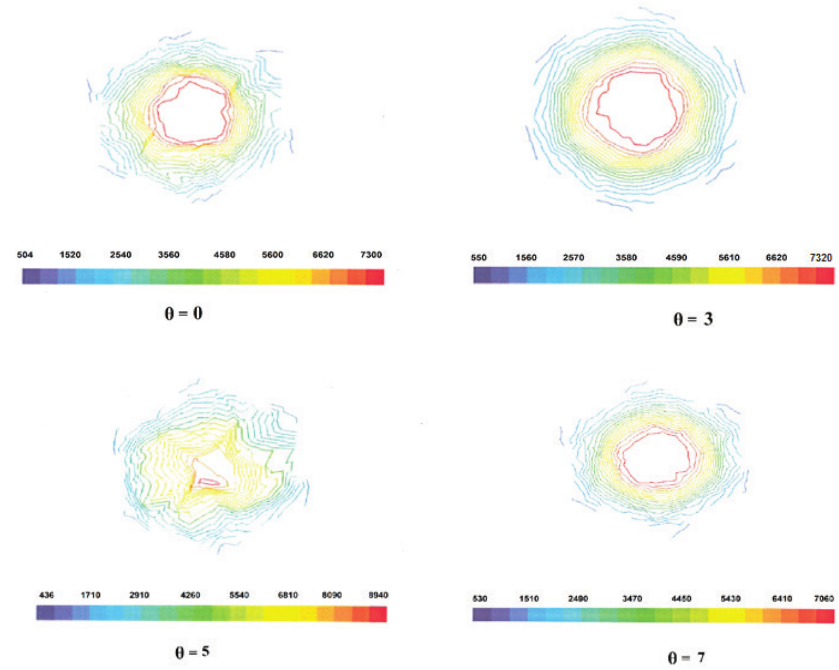
Figure 15. The turbulence kinetic energy contours for axial angle inlet nozzles of θ = 0°, 3°, 5° and